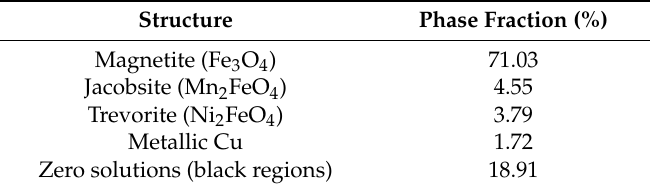
Table 3. Phase fraction of the tube side of the SG flakes using EBSD